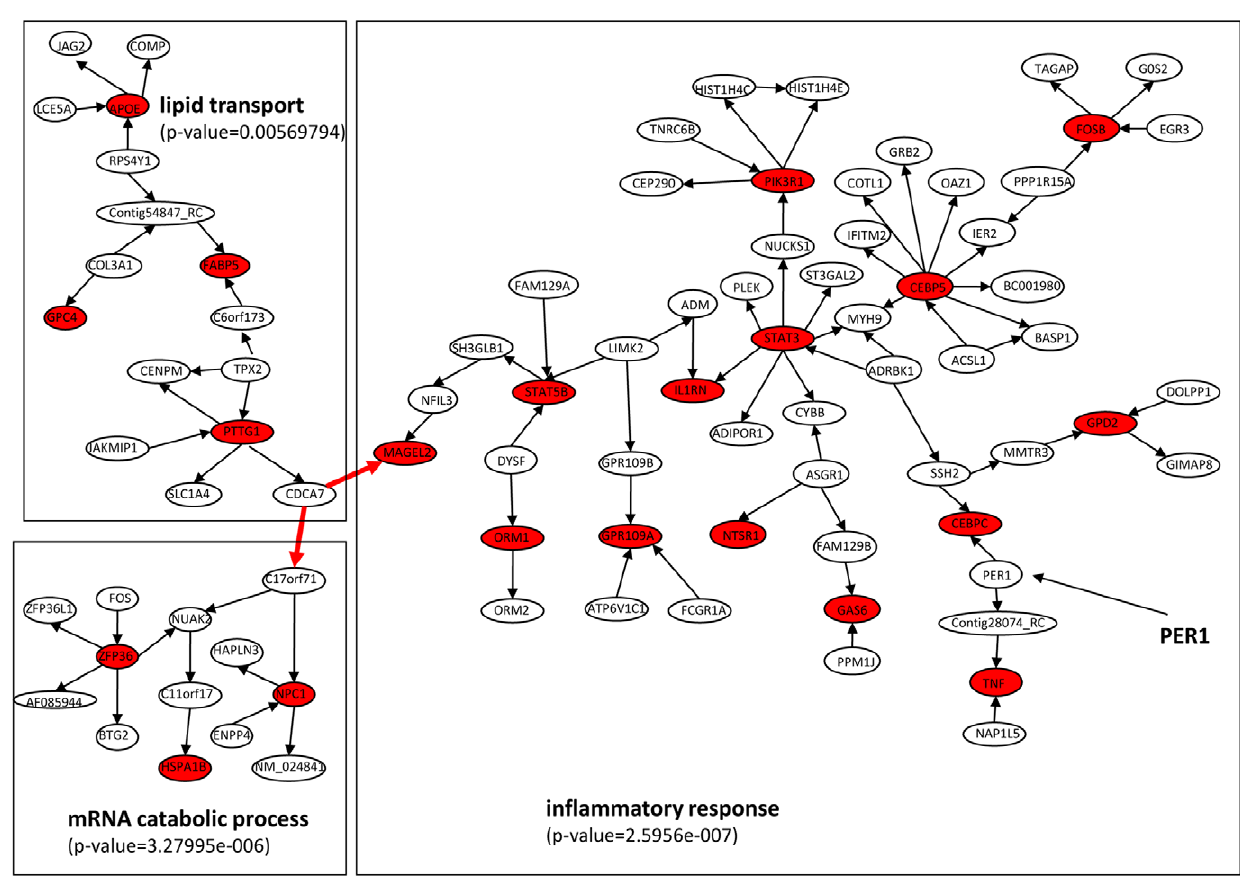
Figure 4. Changes in the obesity causal genes subnetworks between the fed DBN and the SBN. Nodes in red represent obesity causal genes. Edges in black are links in the SBN and Edge in red are inter-slice links in the fed DBN. Three subnetworks in the BN are connected in the fed DBN. The circadian rhythm regulator PER1 is also in the subnetwork.